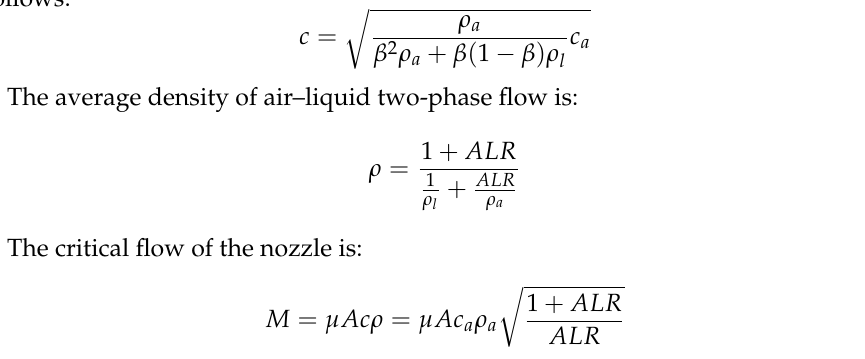
Figure 4. Venturi tube and gas transmission fastening mold installation.